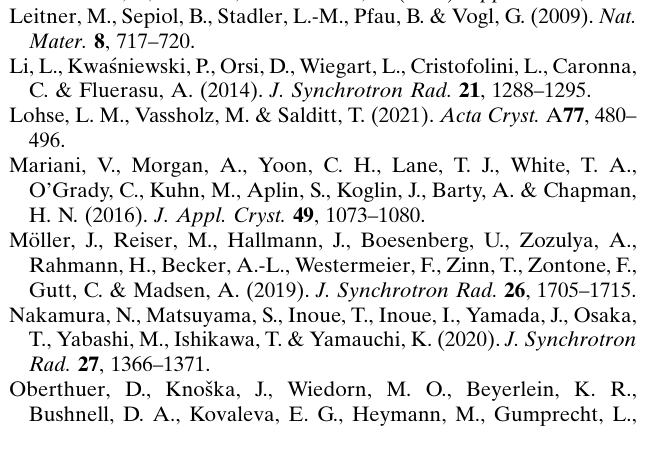
Fabian Trost et al. (cid:3) Speckle contrast of interfering fluorescence X-rays